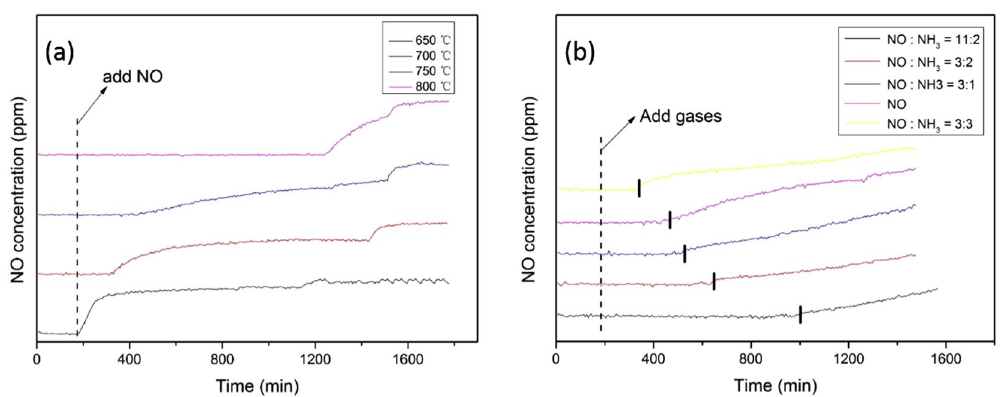
Figure 5. Reaction of NO with ZrP at different temperatures ( a ), Effect of NH 3 concentration on the elimination of NO ( b